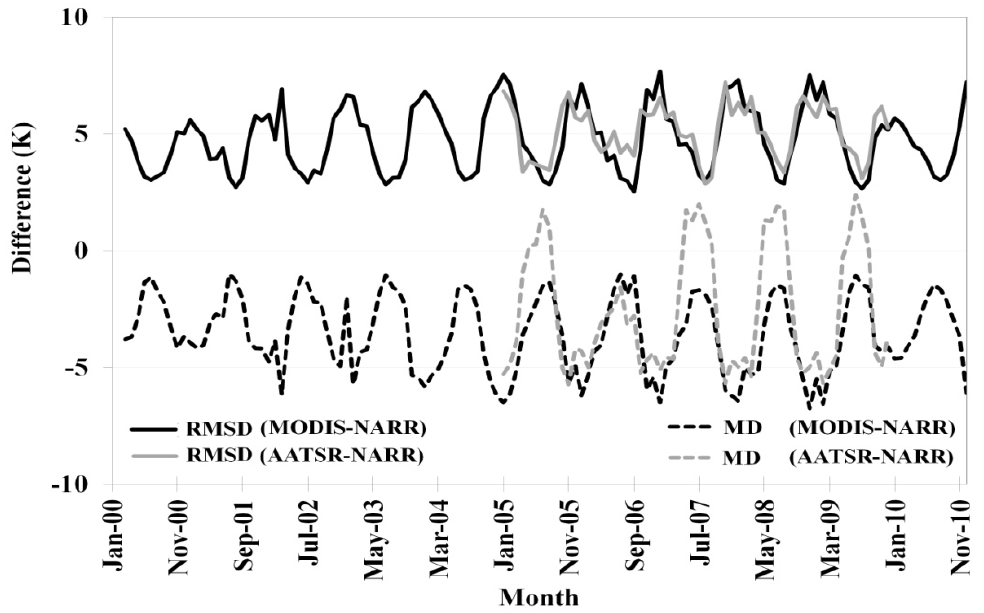
Figure 6. MD and RMSD between monthly UW-L3 of MODIS and AATSR against monthly 0-m height surface temperature of NARR (all-sky average) for the 2000–2010